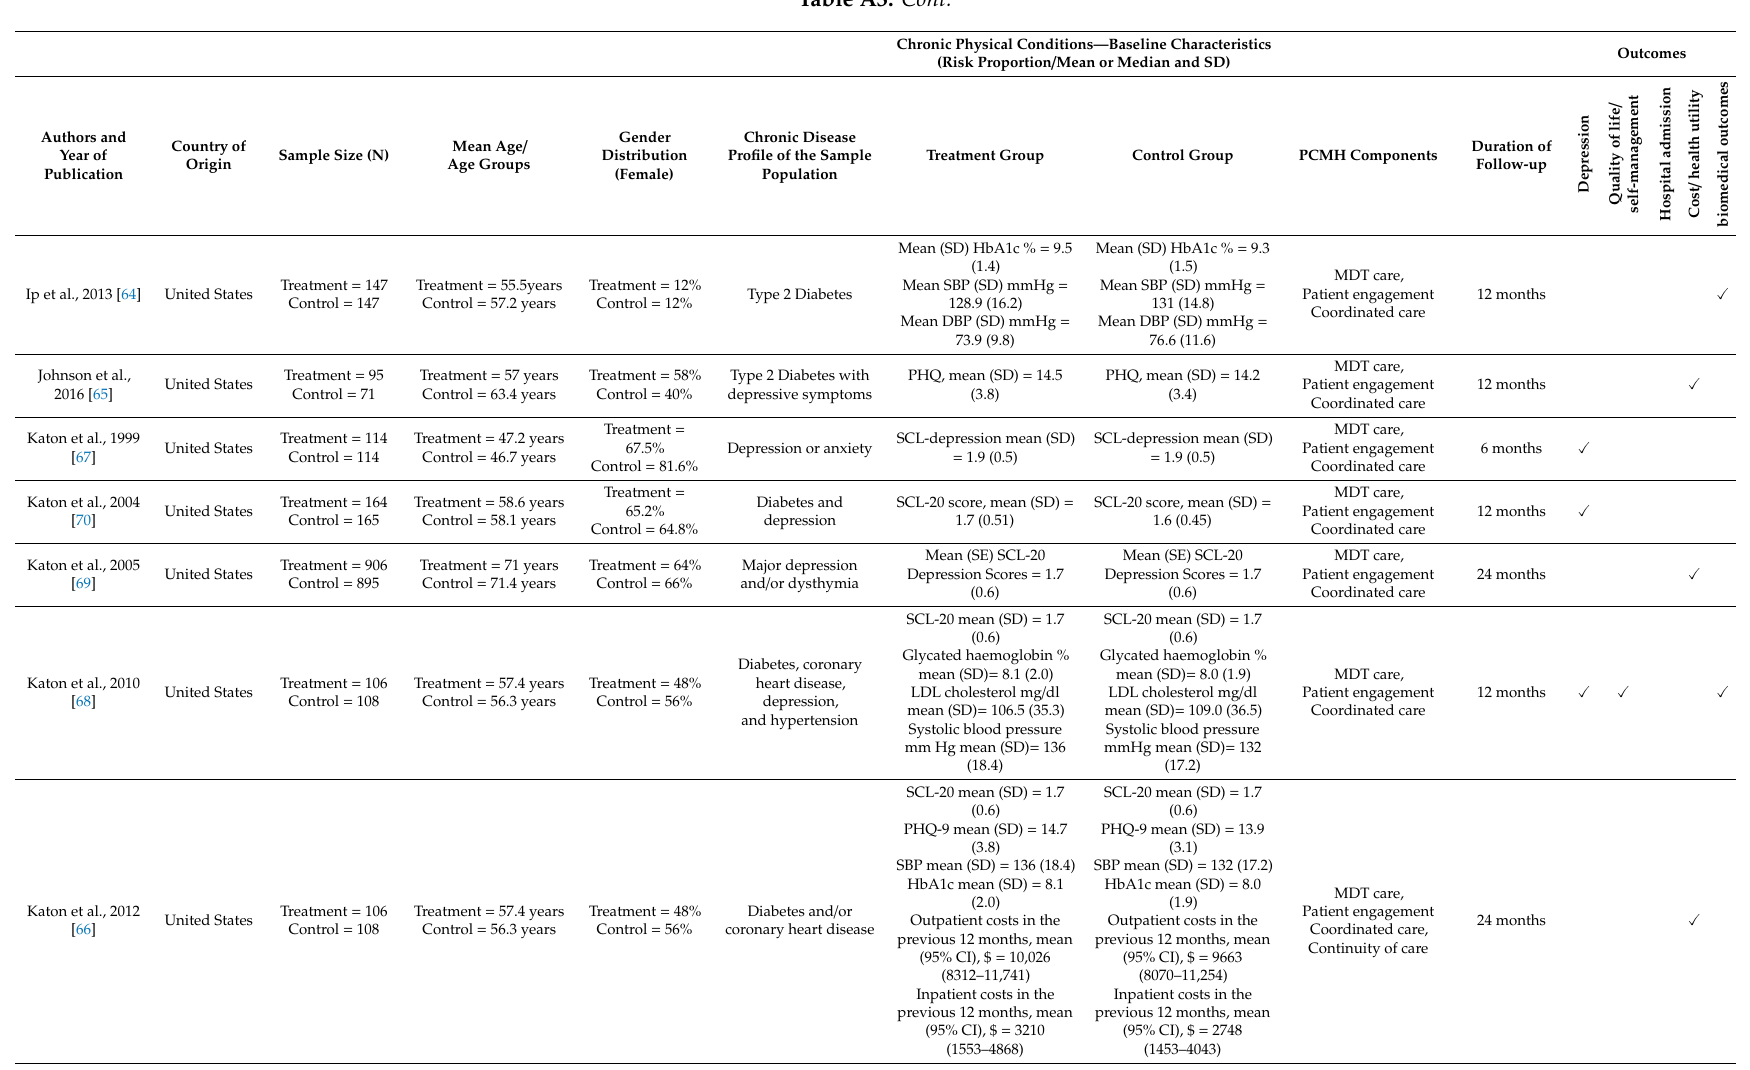
Table A3. Cont. Chronic Physical Conditions—Baseline Characteristics (Risk Proportion / Mean or Median and SD)